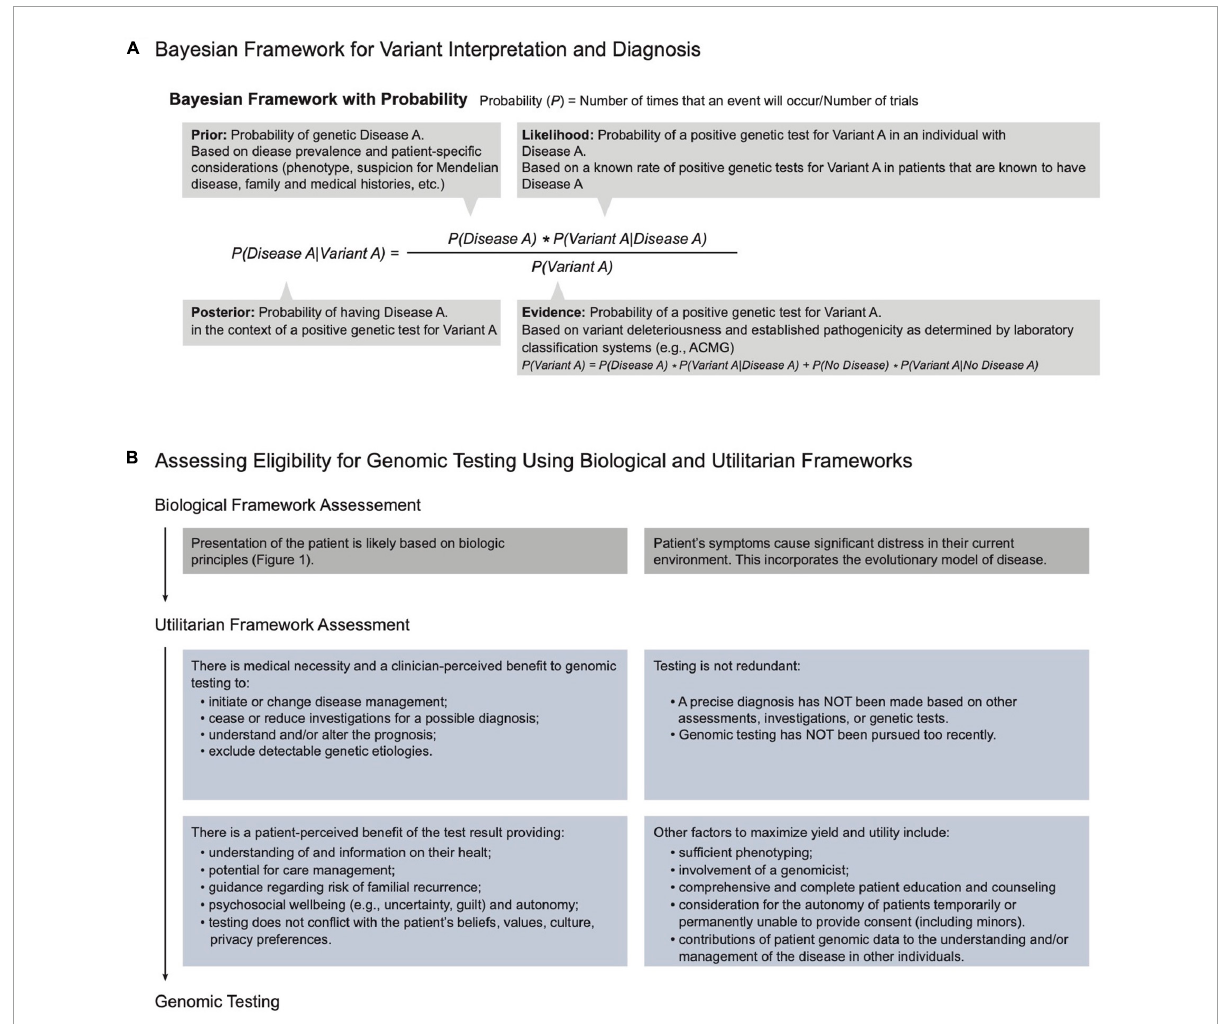
FIGURE3 Principles and frameworks governing genomic medicine. (A) Bayesian framework: A thought process for variant interpretation and diagnosis. Bayes theorem quantifies the probability of “A” being true given some evidence “B.” Applying this framework to genomic diagnosis, we can assess the posterior probability of a patient’s disease (Disease A) being caused by a genetic variant (Variant A) by dividing the product of the prior probability of Disease A and the likelihood of the variant in the context of the disease. As this formula serves to guide a thought process, numerical input and quantification of the probabilities are not required. (B) Assessing eligibility for genomic testing using biologic and utilitarian frameworks. Given that assessment of biological principles suggests that a patient has an increased likelihood of genetic disease ( Figure 1 ), application of a utilitarian framework allocates resources to enable testing that accomplishes societal expectations of benefit, impact, and utility for the patient, the family members, and the